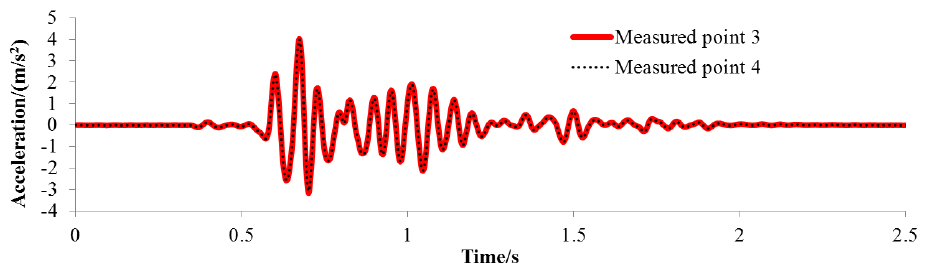
Figure 12. Responded acceleration of typical measured points near the flexible boundary.